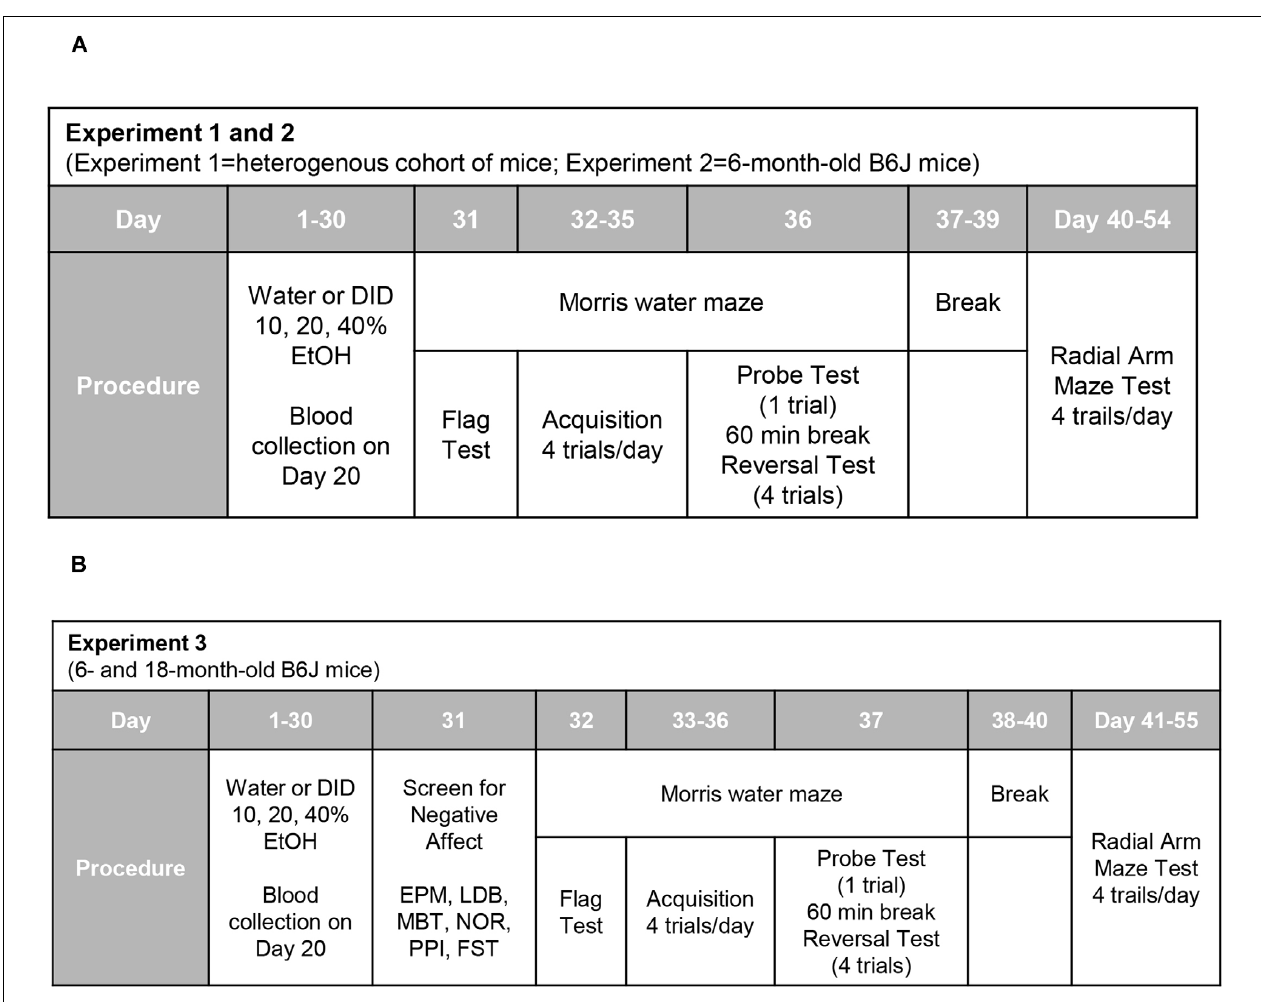
FIGURE 1 | Procedural time-lines of Experiments 1, 2, and 3. (A) In both Experiments 1 and 2, mice underwent a month-long period of binge drinking, followed first by training and testing in a Morris water maze and then, by training in a water version of a radial arm maze. (B) The procedural time-line for Experiment 3 was similar to that of the other two experiments, with the exception that mice underwent a 1-day behavioral test battery for negative affect prior to Morris water and radial arm maze